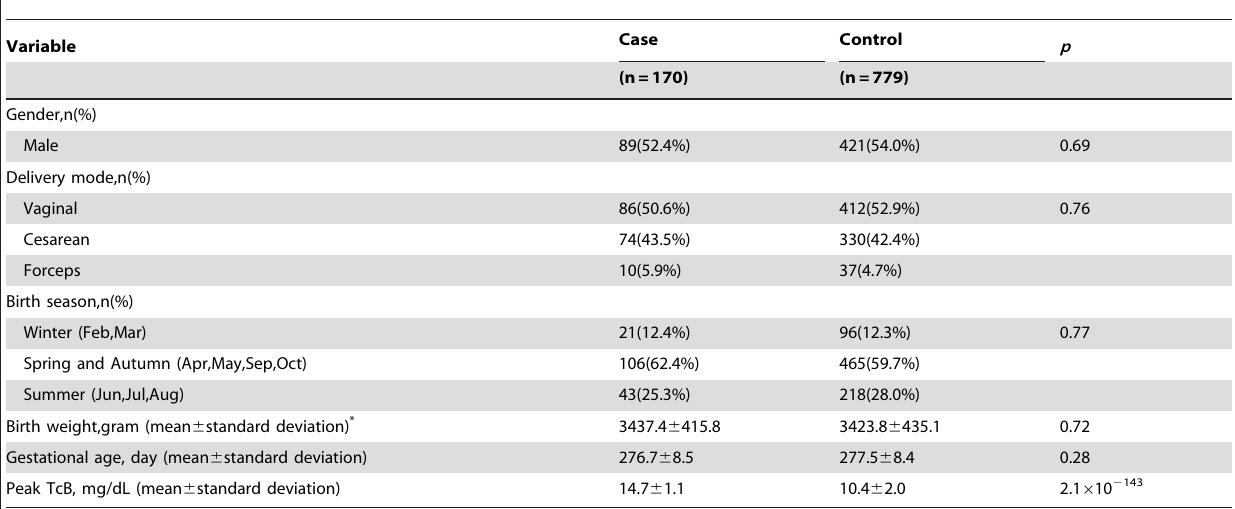
Table 2. Characteristics of hyperbilirubinemic patients and